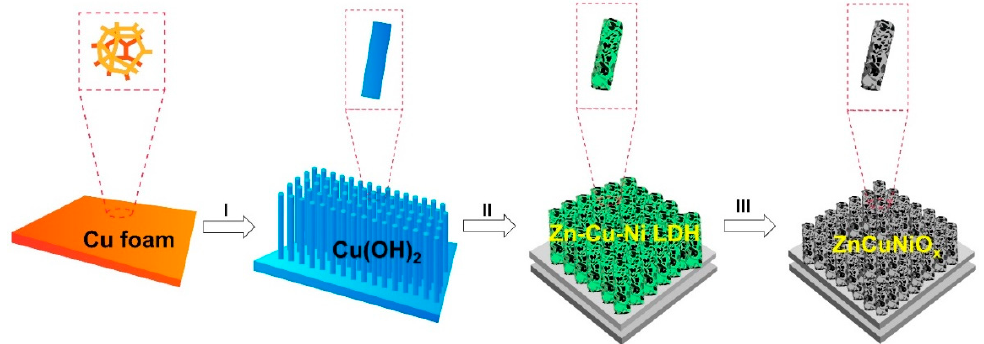
Figure 1. Schematic formation procedure of the CF@Cu(OH) 2 , CF@Cu(OH) 2 @Zn-Cu-Ni LDH, and CF@ZnCuNiO x Nas.